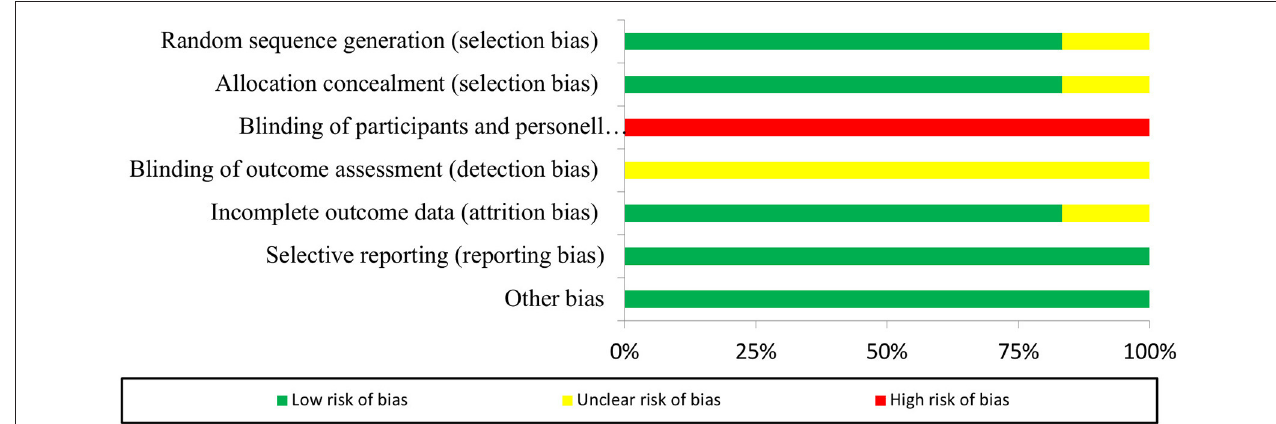
FIGURE 3 | Risk of bias summary for the n = 5 included randomized studies ( n = 1 non-randomized study not included).